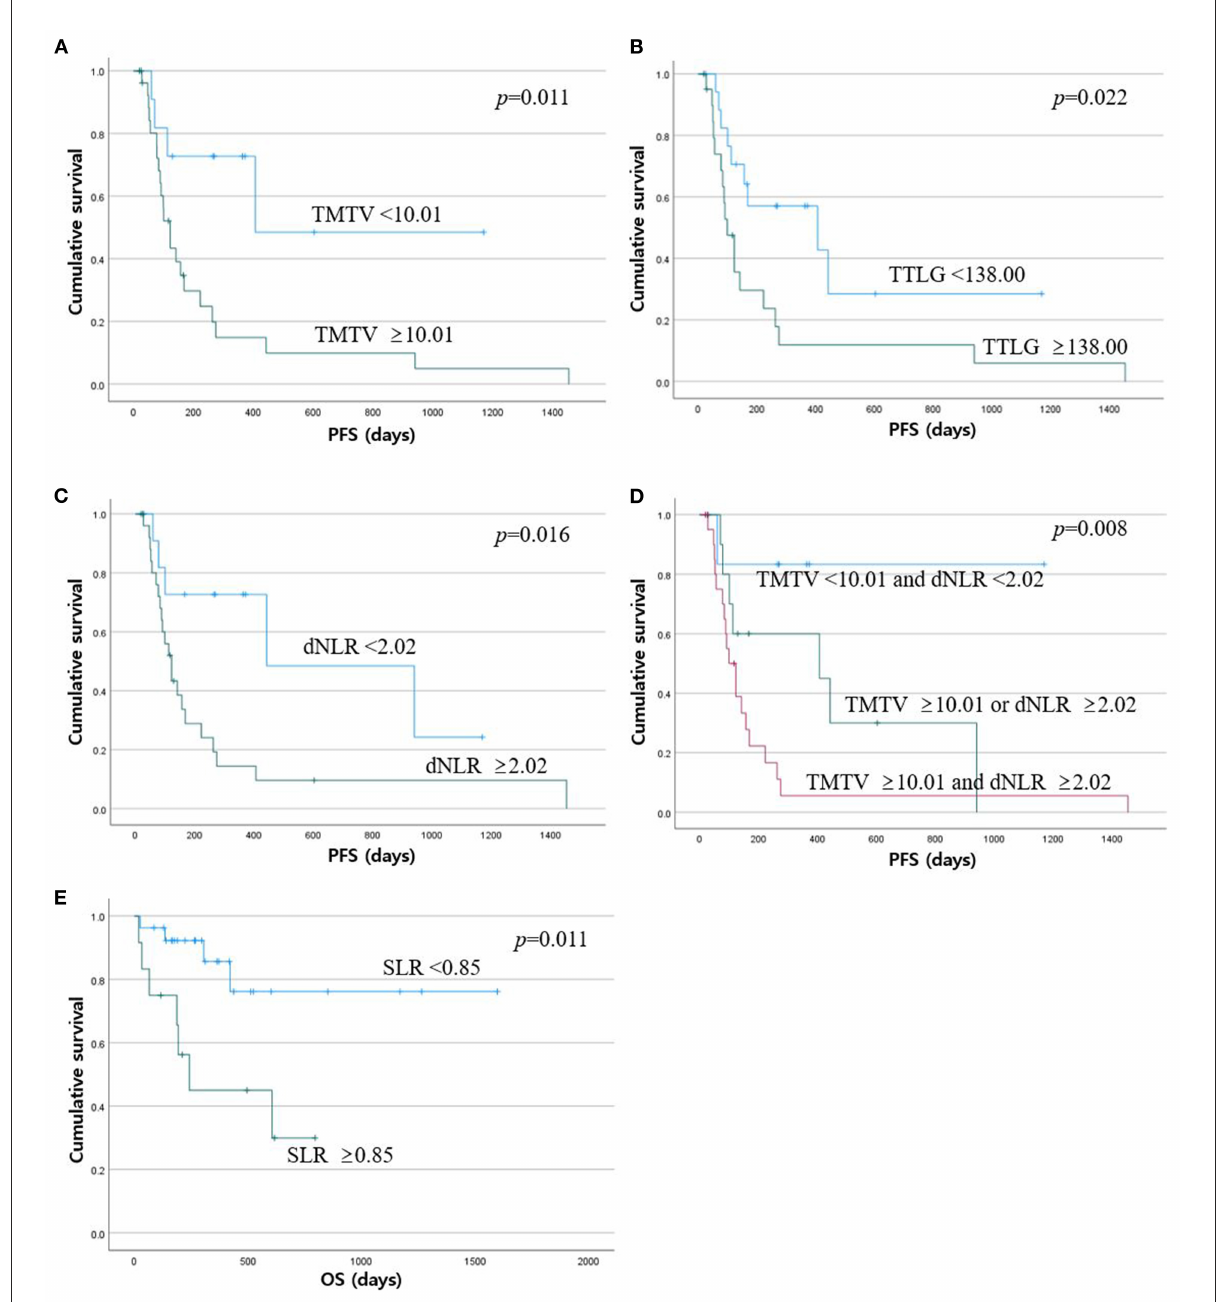
FIGURE2 Kaplan-Meier curves with log-rank test for progression-free survival and overall survival. Patients with high TMTV (A) , high TTLG (B) , and high dNLR (C) showed shorter progression-free survival. (D) Progression-free survival became shorter from Group 1 to Group 3 for the combined parameter. (E) Patients with high SLR had shorter overall survival.